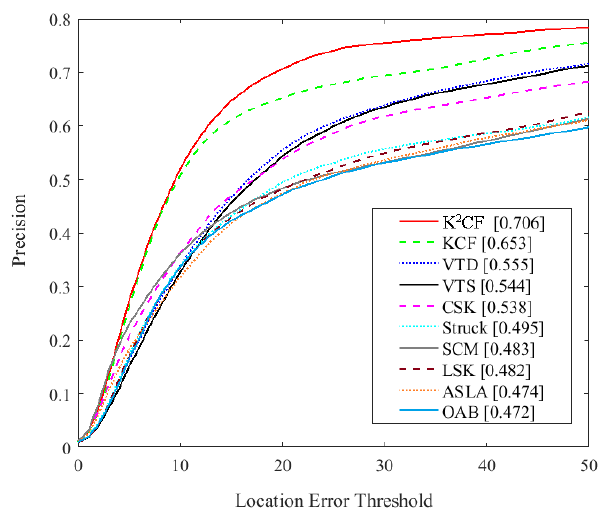
Figure 20. Comparison of state-of-the-art trackers.